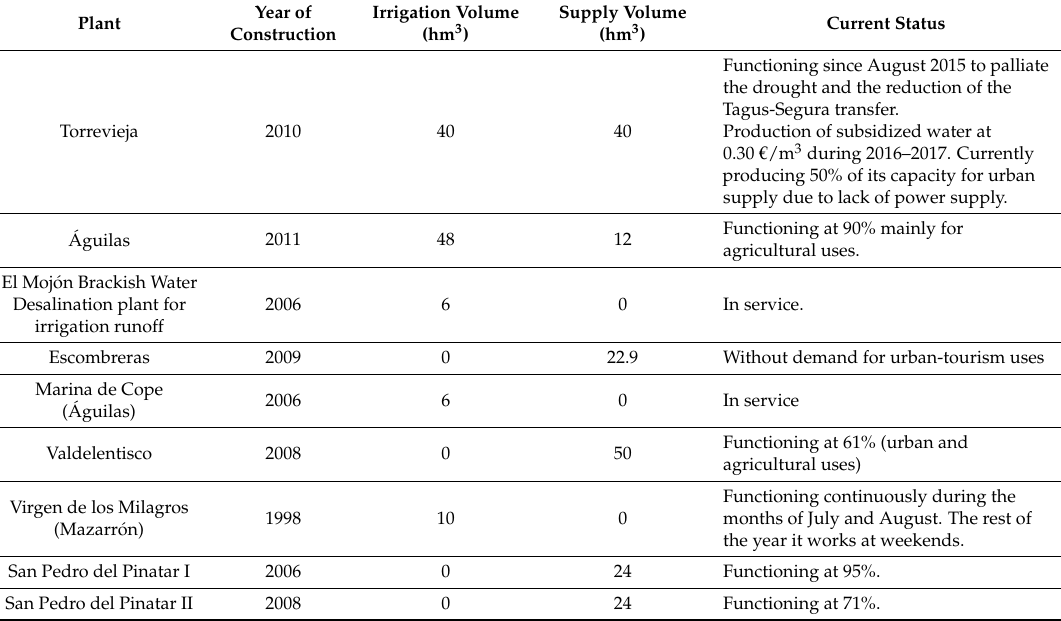
Table 2. Situation of the main desalination plants in the Segura River Basin